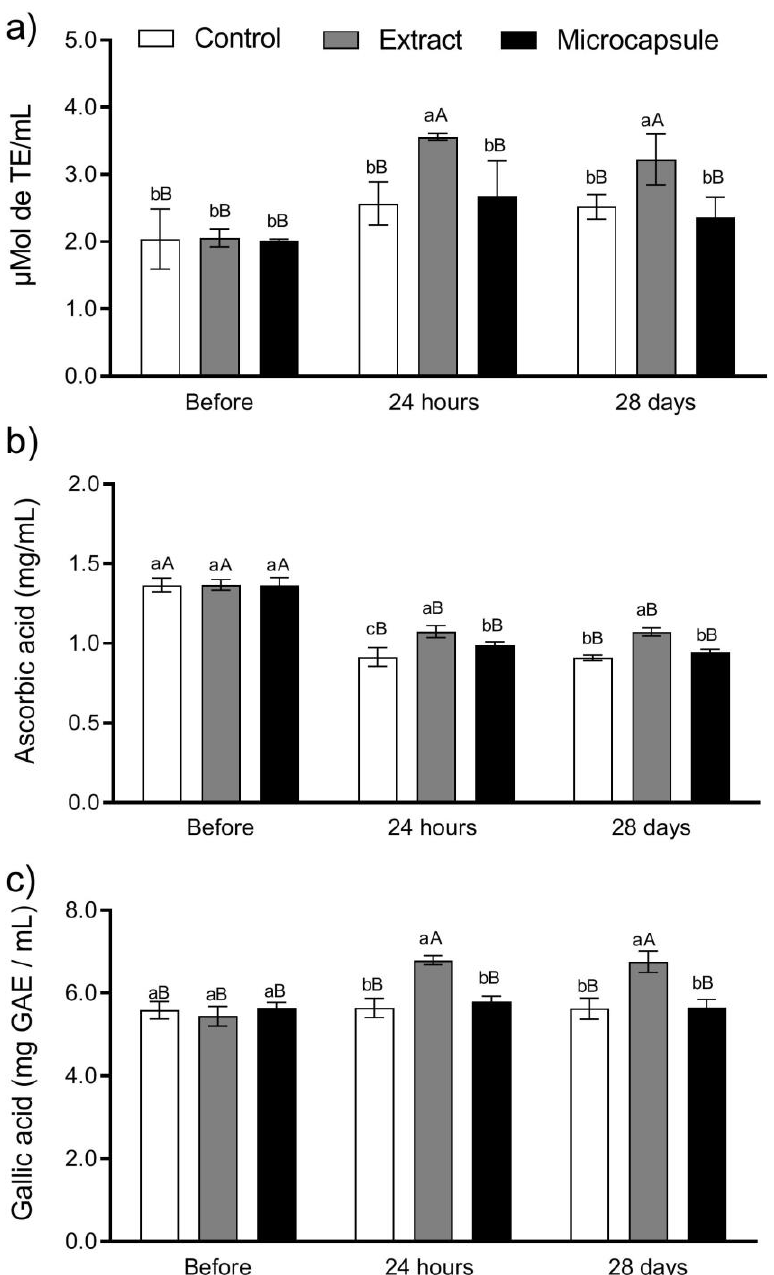
Figure 6. Antioxidant activity by ABTS radical reduction, the phosphomolybdenum complex method, and the total phenolic content. ( a ) Antioxidant activity by the ABTS radical reduction method. ( b ) Antioxidant activity by the phosphomolybdenum complex method. ( c ) Total phenolic content. Different lowercase letters denote differences ( p < 0.05) among assays simultaneously. Different capital letters denote the same assay’s difference ( p < 0.05) at different times according to the Scott– Knott test. [Non-dairy matrix (N-DM): 1 Control—consists only of the fermented beverage (N-DM); 2 Extract—beverage (N-DM) with propolis extract (DPE); 3 Microcapsule—beverage (N-DM) with microencapsulated propolis